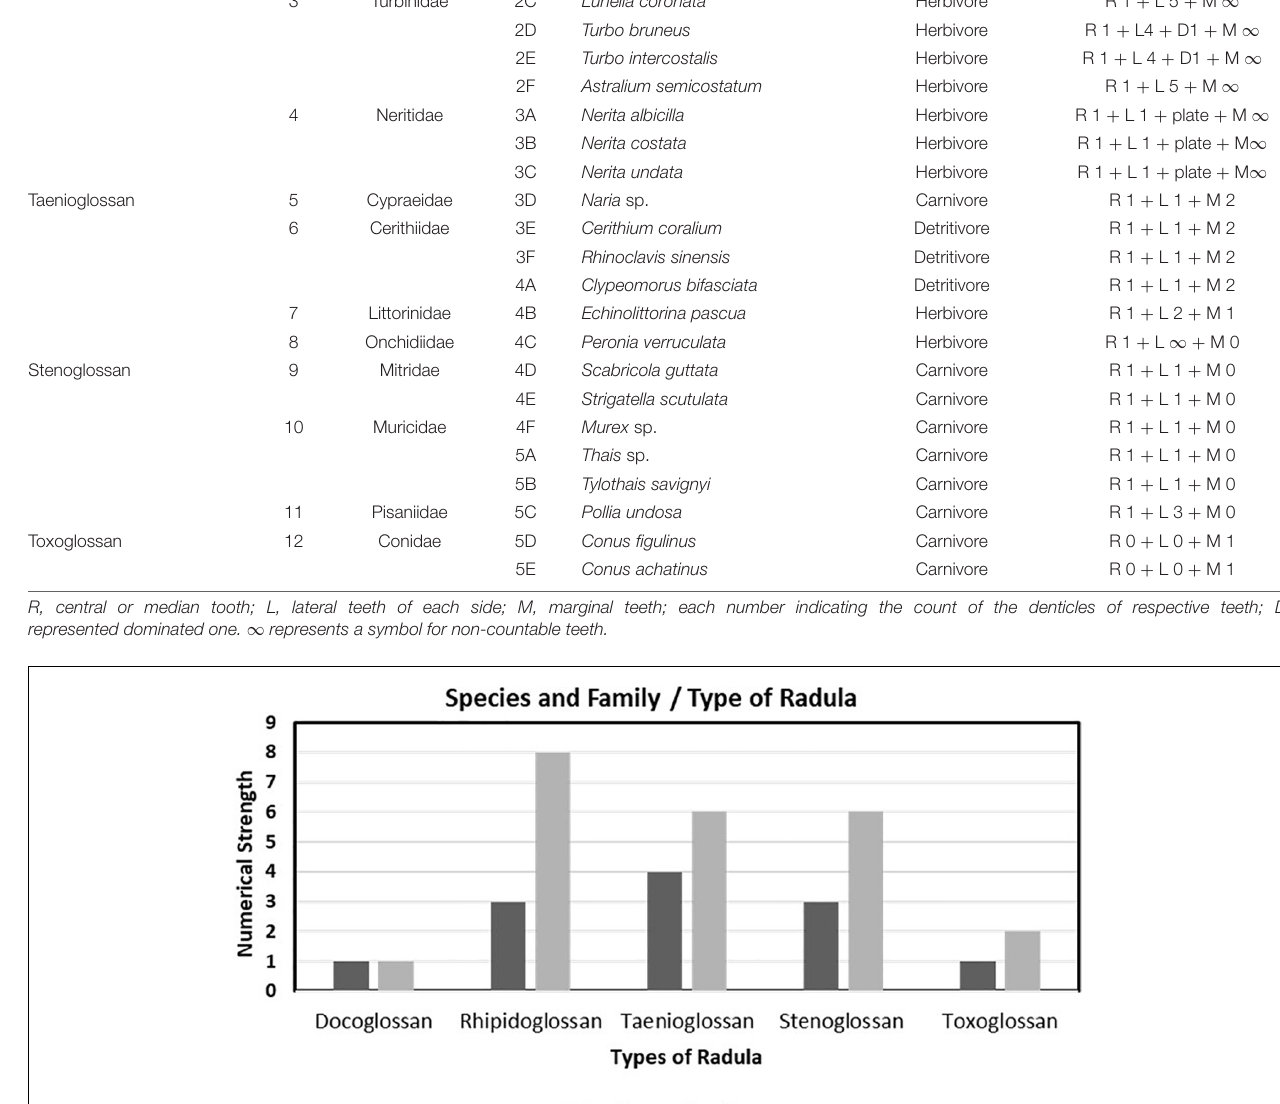
In Cypraeidae, radula, the rachidian tooth observed with a moderately broad base which is curved and less pointed from the front, also has one lateral and two marginal teeth ( Table 1 ). In Naria sp., a single rachidian tooth looks similar to Serpentes hood shape followed by one lateral tooth, where marginal teeth are observed bifurcated anteriorly into two sharp pointed structure ( Figure 3D ) ( Naria sp.